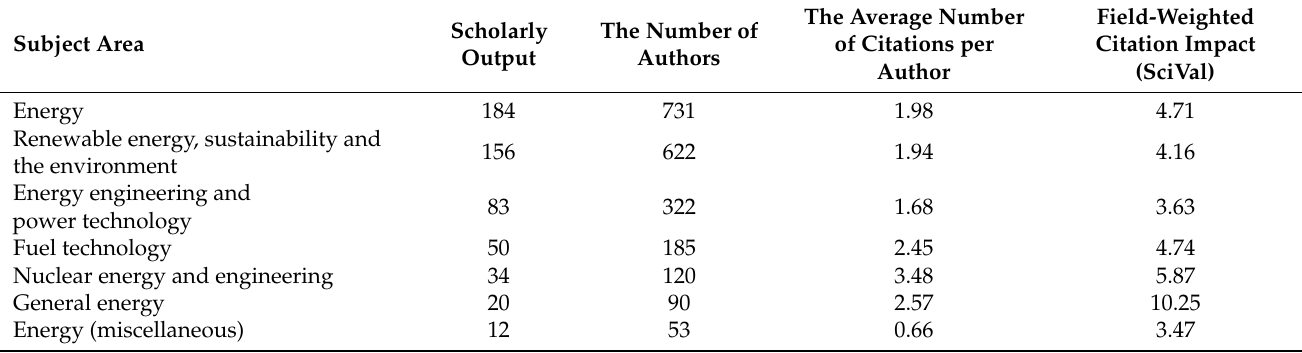
Table 1. Publications by the subject area of renewable energy, sustainability, and the environment (within energy area), 2019–2021.